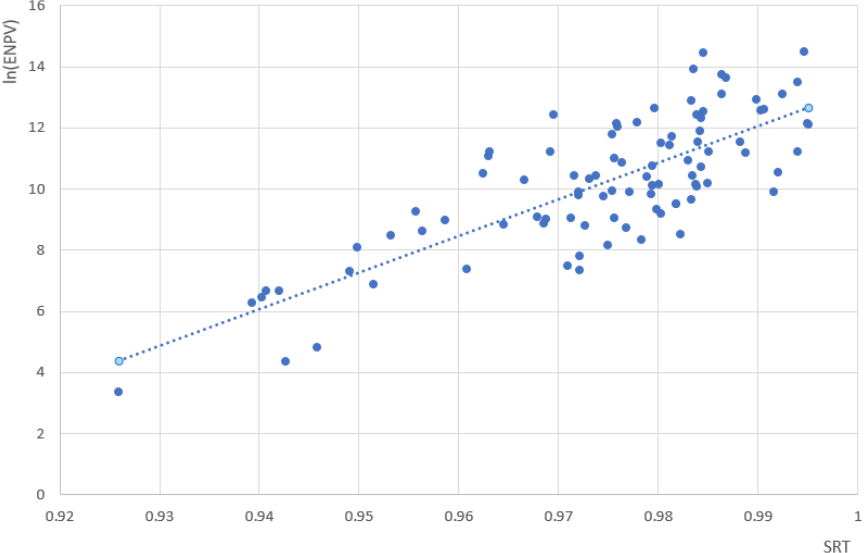
Figure 2. Regression results of SRT coefficients and NPV.